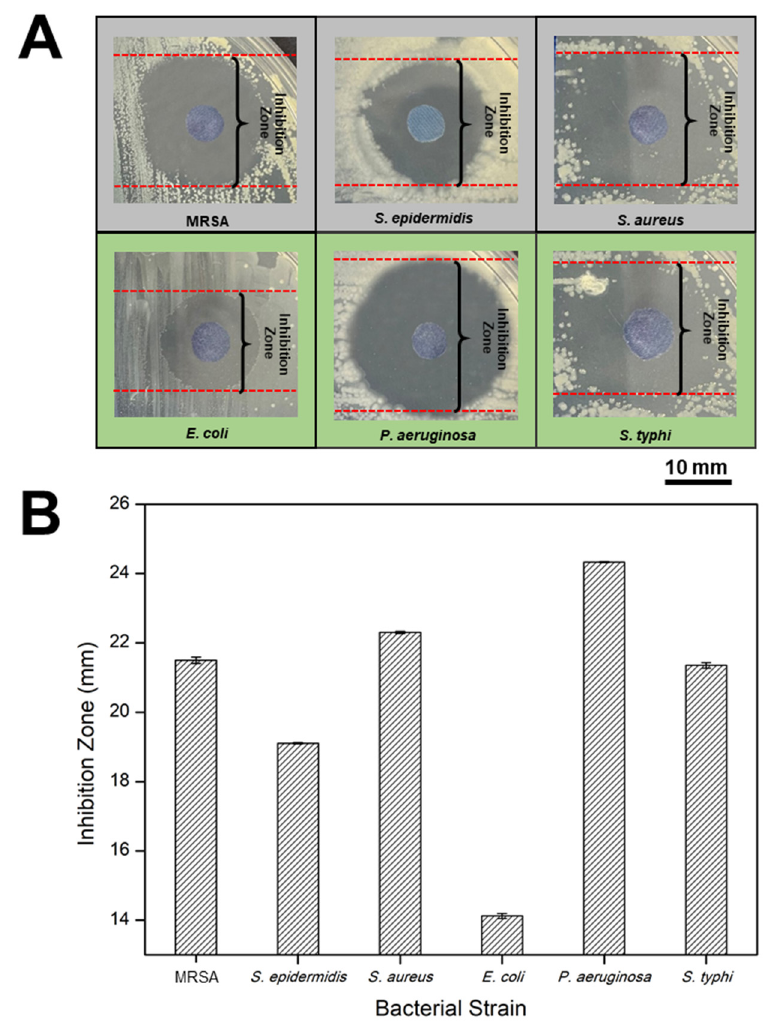
Figure 4. ( A ) Close-up images of inhibition zones formed and ( B ) the inhibition zone values (mm) of each selected bacteria species around the surface of protonated PANI fabric after 18 h of